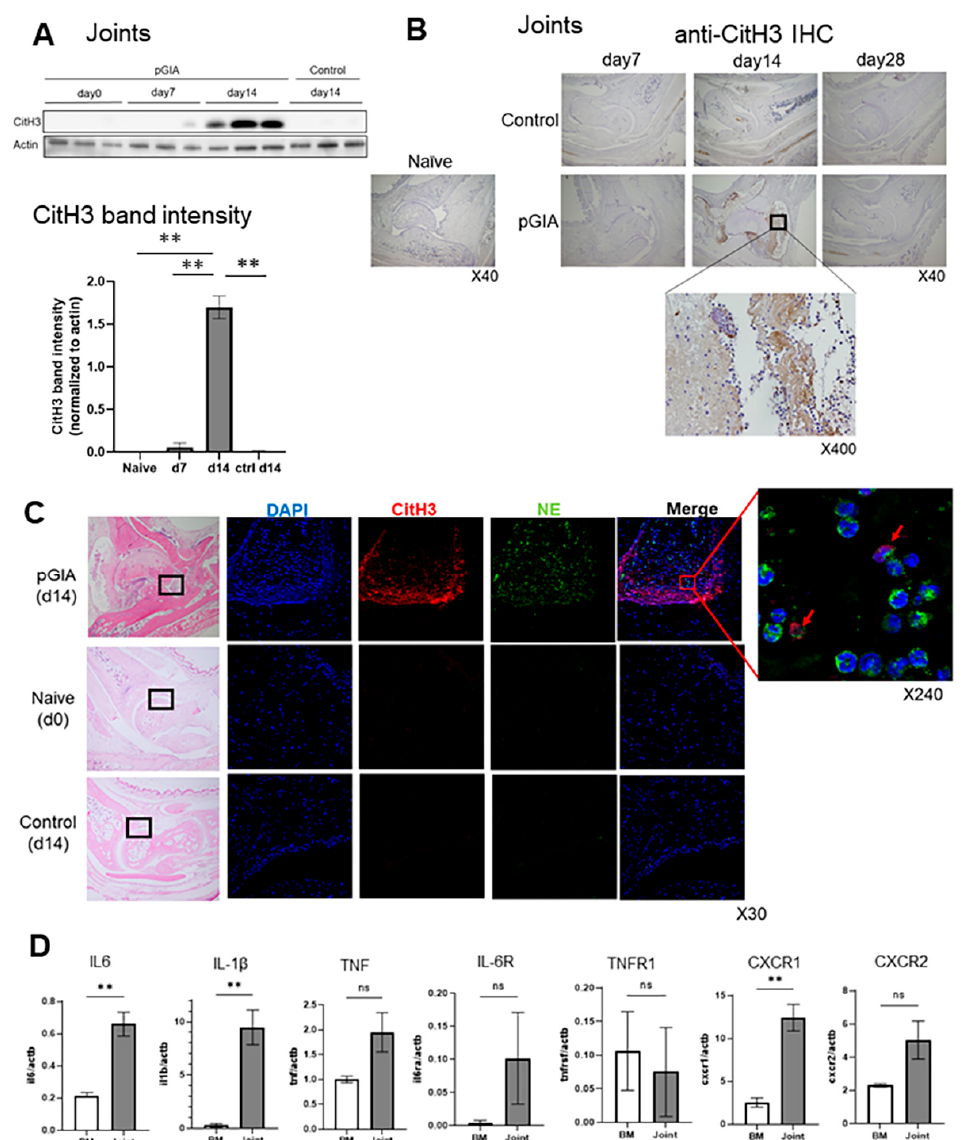
Figure 2. Citrullinated histone 3 (CitH3) expression in the arthritic joints of pGIA mice. ( A ) Joint lysates from pGIA mice at days 0, 7, and 14 and from control mice at day 14 were subjected to Western blot analysis using anti-CitH3 antibodies. Three mice were examined, and p values were calculated using ordinary one-way ANOVA with the post hoc Tukey test for multiple comparisons; ** p < 0.01. ( B ) Joint sections from pGIA and control mice were immunohistochemically stained with anti-CitH3 antibodies. Hematoxylin was used as the counterstain. ( C ) Immunofluorescence using anti-CitH3 antibodies and anti-neutrophil elastase (NE) antibodies was performed on joint sections from the pGIA mice at day 14 and from the naïve mice and control mice at day 14. DAPI was used for DNA staining. Box was enlarged image of the located portion, and red arrows are overlayed portion with CitH3 and NE. ( D ) Reverse transcription quantitative PCR was performed with neutrophils from the joints and bone marrow of the pGIA mice at day 14. Each gene expression value was normalized to actin. Data indicate means ± SEMs. p values were calculated using the unpaired t -test; ** p <